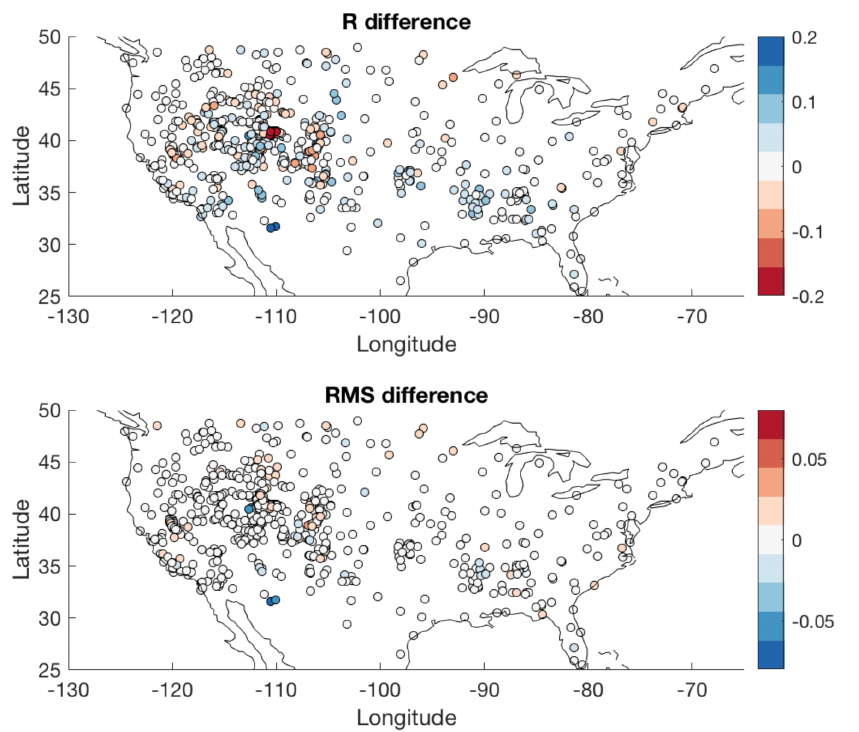
Figure 9. ( Upper ) difference of the Pearson correlation of NNSM experiment time series with respect to in situ measurements and the Pearson correlation of OL experiment time series with respect to in situ measurements. ( Lower ) difference of the RMS of NNSM experiment time series with respect to in situ measurements and RMS of OL experiment time series with respect to in situ measurements. In both cases, blue points show that the analysed time series are closer to the in situ measurement (higher correlation and lower